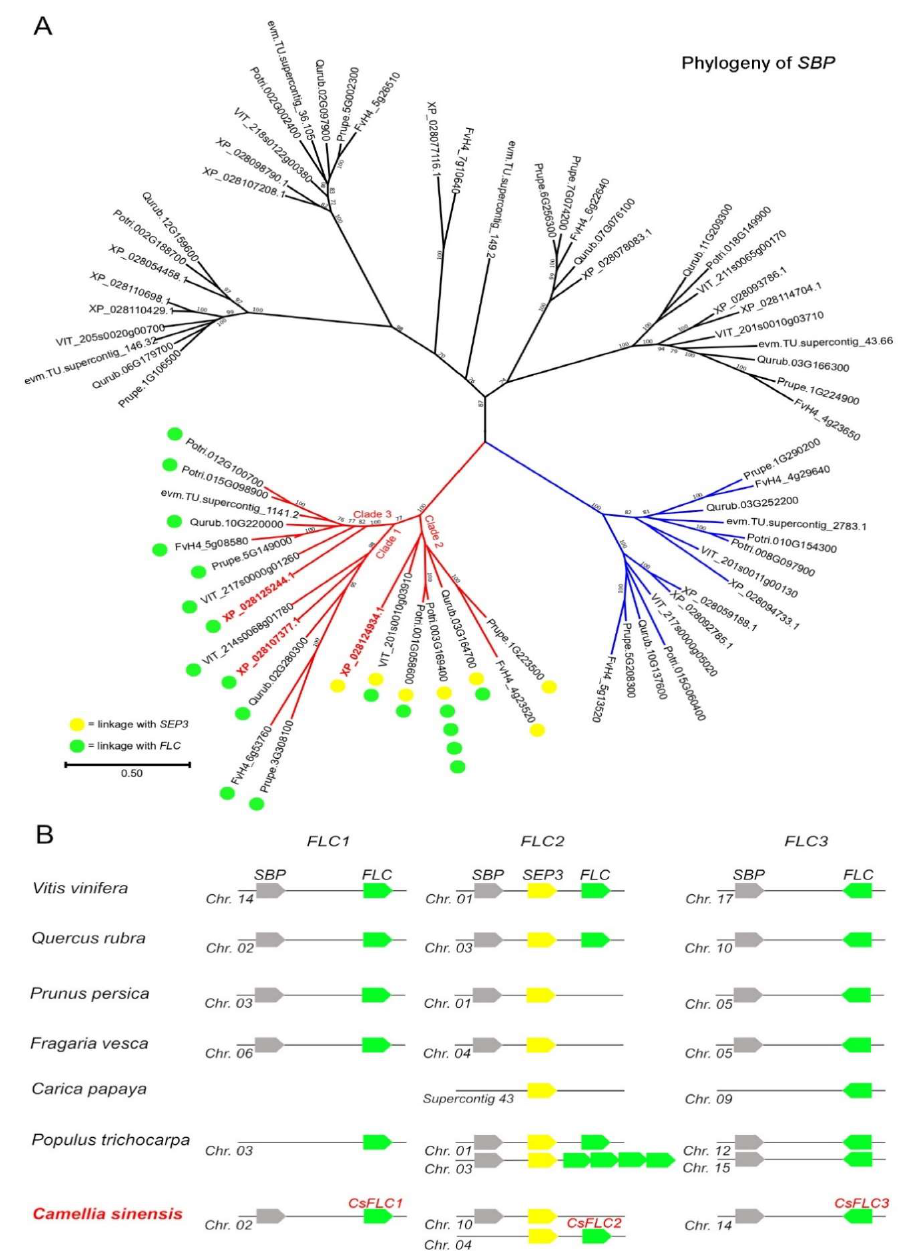
Figure 1. Identification and characterization of CsFLC genes. ( A ). As reported earlier by Ruelen et al. [30], SBP genes from a conserved monophyletic clade, shown in red, are closely linked to SEP3 and FLC , and they are triplicated in core eudicots (clades 1, 2 and 3). Two of the three SBP genes that we found in Camellia sinensis show this conserved linkage with FLC genes. The genes of sister clade shown in blue are instead linked to LOFSEP and SQUA MADS-box genes. Potri: Populus trichocarpa ; VIT: Vitis vinifera ; XP: Camellia sinensis ; Prupe: Prunus persica ; FvH4: Fragaria vesca ; Qurub: Quercus rubra ; evm: Carica papaya . The tree was generated using protein sequences. Bootstrap values lower than 70 are not shown, and the scale bar indicates the number of amino acid sequence substitutions per site. ( B ). The three SBP -( SEP3 )- FLC paralogous tandems of core eudicots show different patterns of conservation and duplications among species. In Camellia sinensis , which has an ancient tetraploid genome [32], six regions are expected; however, only duplicated copies of SEP3 were retained. The results of this analysis suggest the presence of only three FLC genes in tea plant, which we refer to as CsFLC1 , CsFLC2 and CsFLC3 .